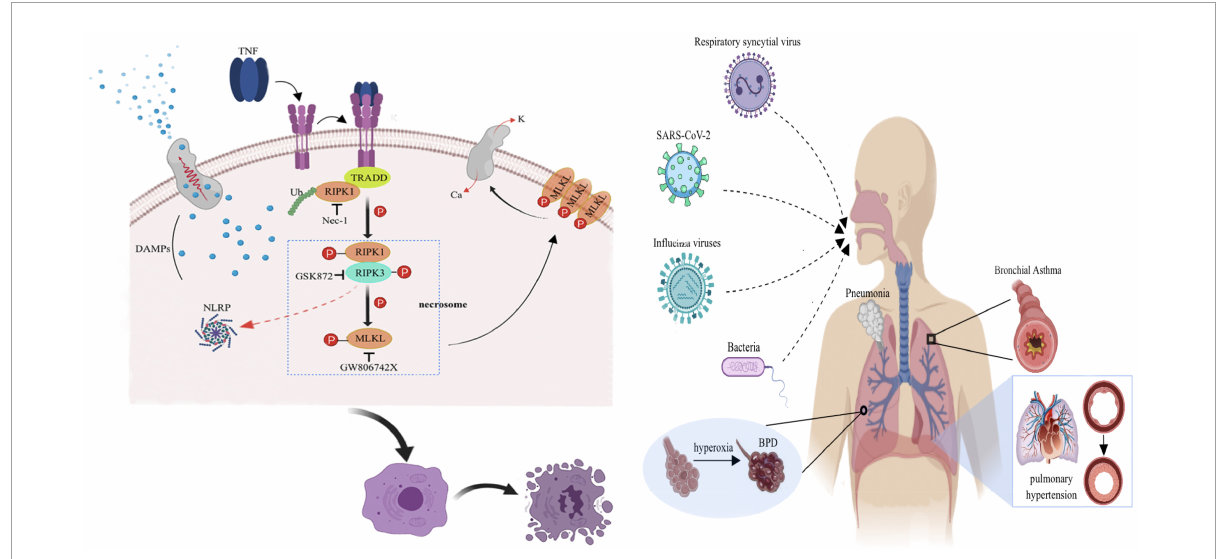
FIGURE1 Schematic diagram of the molecular mechanism of TNF- α -mediated NEC.